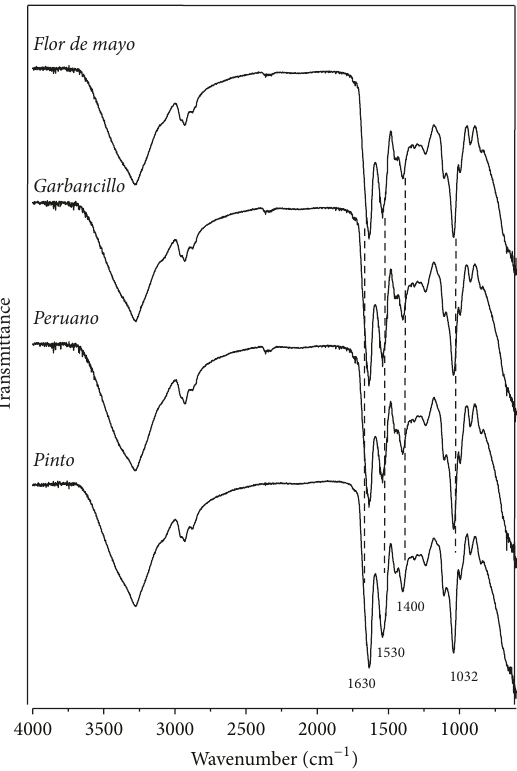
Figure 5: Fourier transform infrared spectra of the tested proteina- ceous edible films from four of the studied bean varieties. occurs between the studied protein concentrates and glycerol in the tested films could be due to the presence of hydrogen